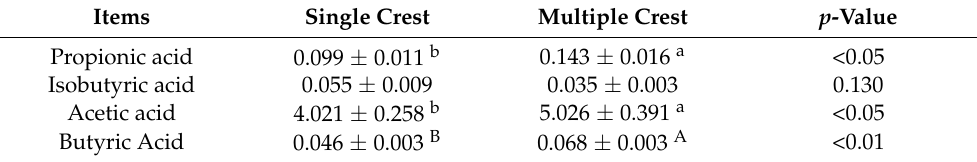
Table 8. Effect of crown cushions on short-chain fatty acids in serum biochemical parameters. Items Single Crest Multiple Crest p -Value Propionic acid 0.099 ± 0.011 b 0.143 ± 0.016 a <0.05 Isobutyric acid 0.055 ± 0.009 0.035 ± 0.003 0.130 Acetic acid 4.021 ± 0.258 b 5.026 ± 0.391 a <0.05 Butyric